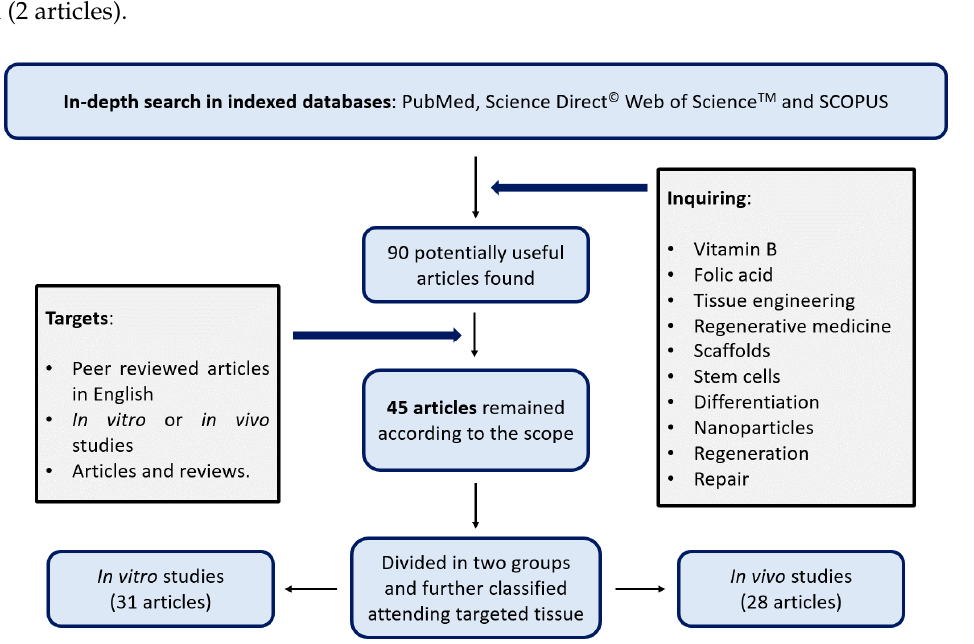
Figure 1. Flow diagram of the screening process carried out on this review.